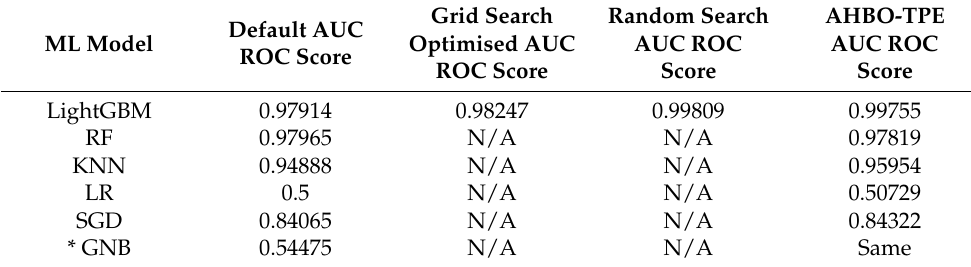
Table 7. Score comparisons for the Application of HPO (Kaggle Dataset).